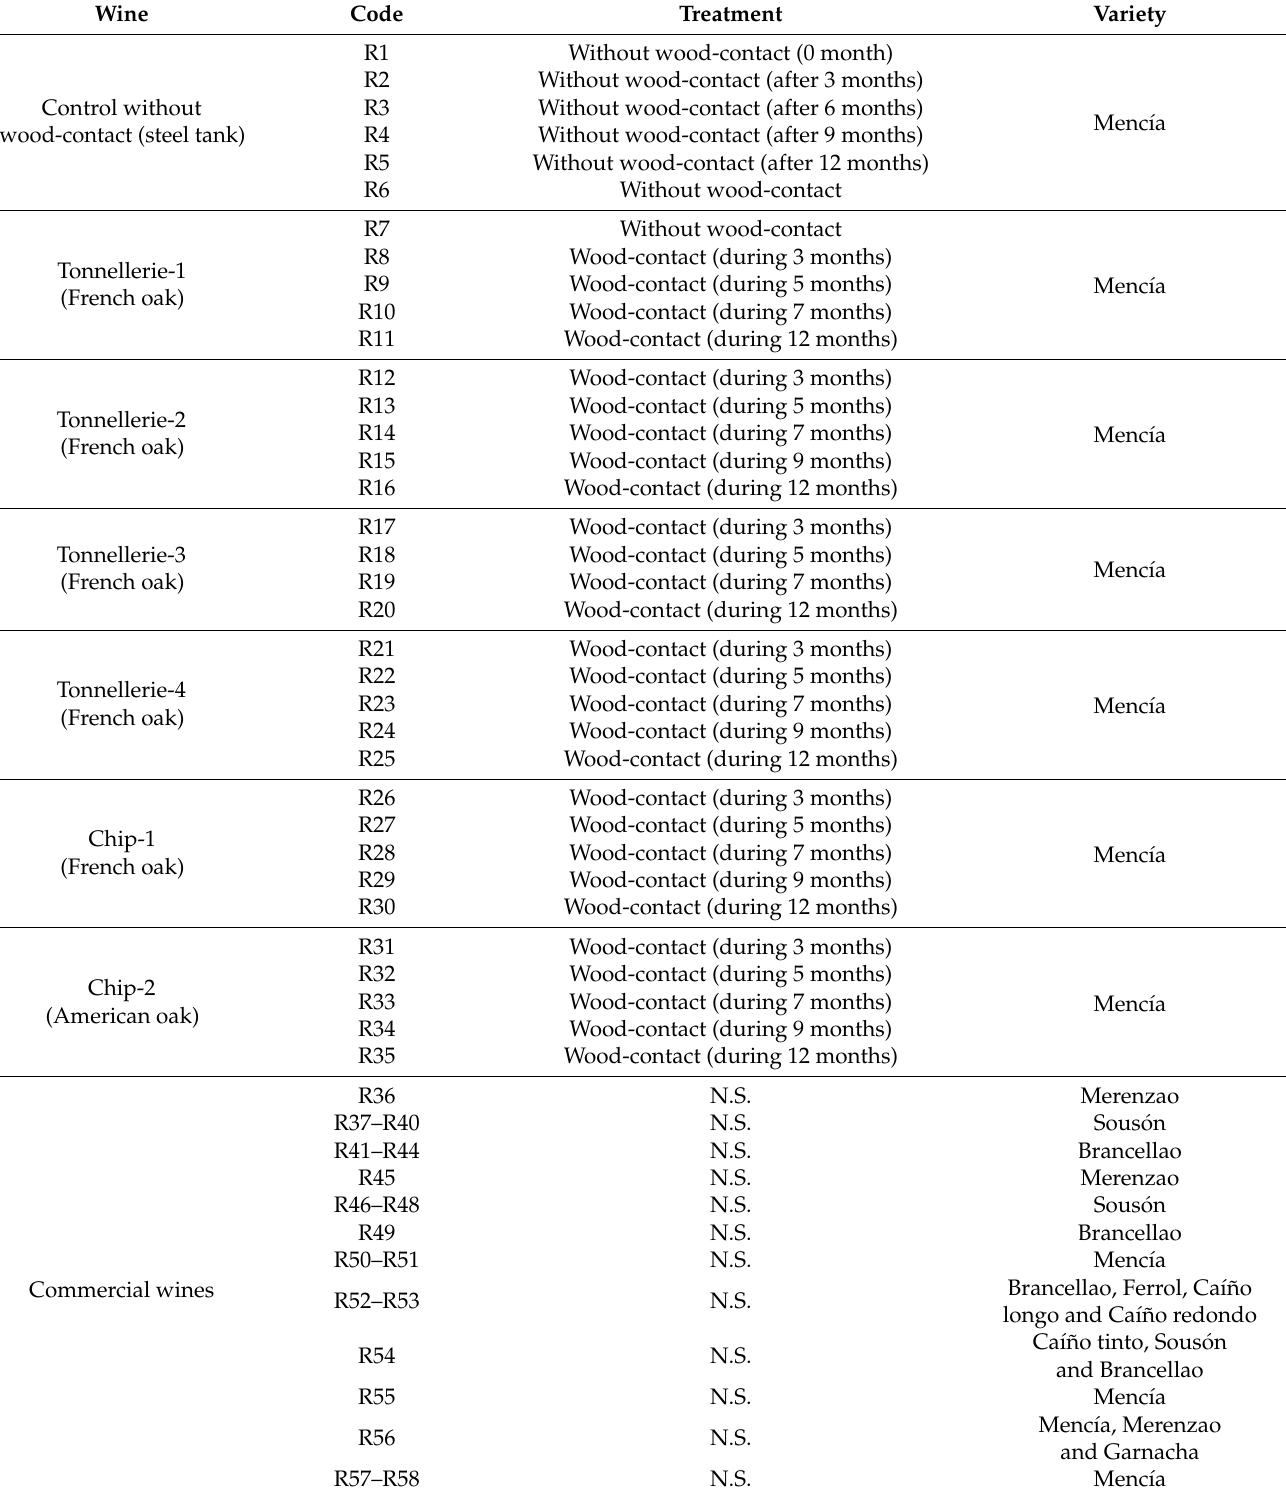
Table 4. Nomenclature and characteristics of red wine